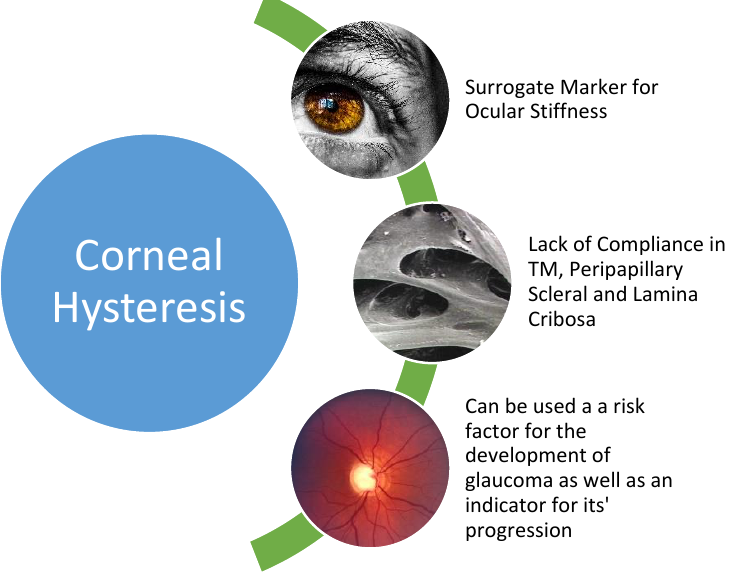
Figure 1. Corneal hysteresis is a surrogate marker for glaucoma and can be utilised to risk-stratify both those who are in danger of developing the disease and also those who are likely to progress (TM: trabecular meshwork).